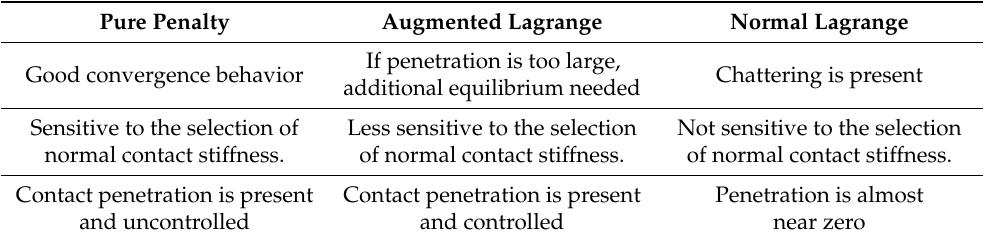
Table 5. Summary of contact formulations available in ANSYS and the criteria of each contact type [98]. Pure Penalty Augmented Lagrange Normal Lagrange If penetration is too large, Good convergence behavior Chattering is present additional equilibrium needed Sensitive to the selection of Less sensitive to the selection Not sensitive to the selection normal contact stiffness. of normal contact stiffness. of normal contact stiffness. Contact penetration is present Contact penetration is present Penetration is almost and uncontrolled and controlled near